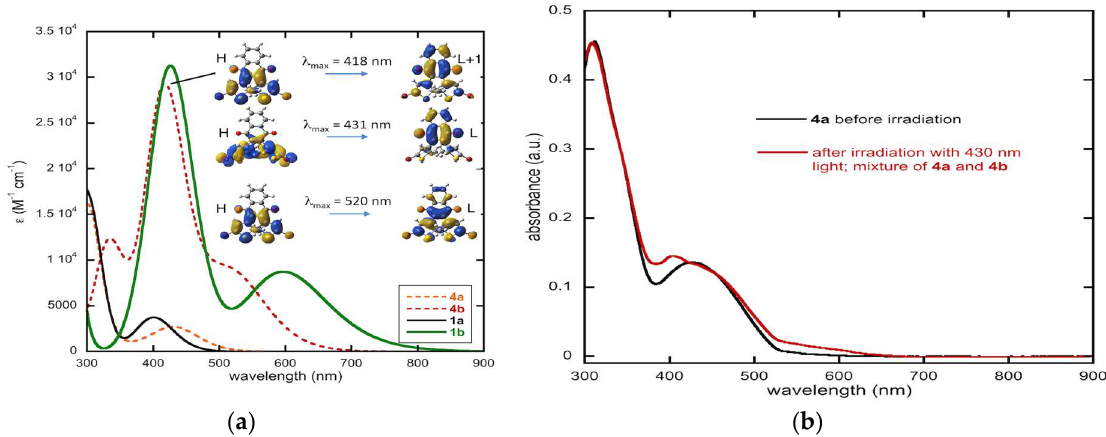
Figure 10. ( a ) Computed spectrum of 4a and 4b in dichloromethane at TD-DFT level and molecular orbitals (H: HOMO, L: LUMO, isocontour: 0.02) involved in the main electronic transitions. The computed spectra of 1a and 1b are shown for comparison. ( b ) Experimental spectrum of 4a and the spectrum obtained after irradiation of 4a with 430 nm wavelength